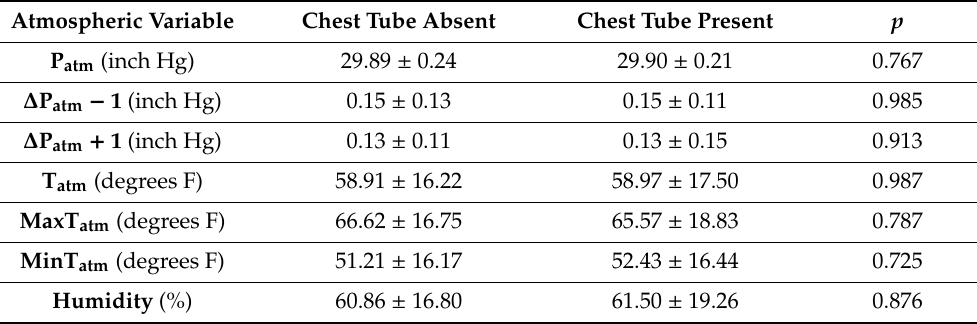
Table 5. E ff ect of the atmospheric variables on the rate of chest tube placement after CT-guided lung